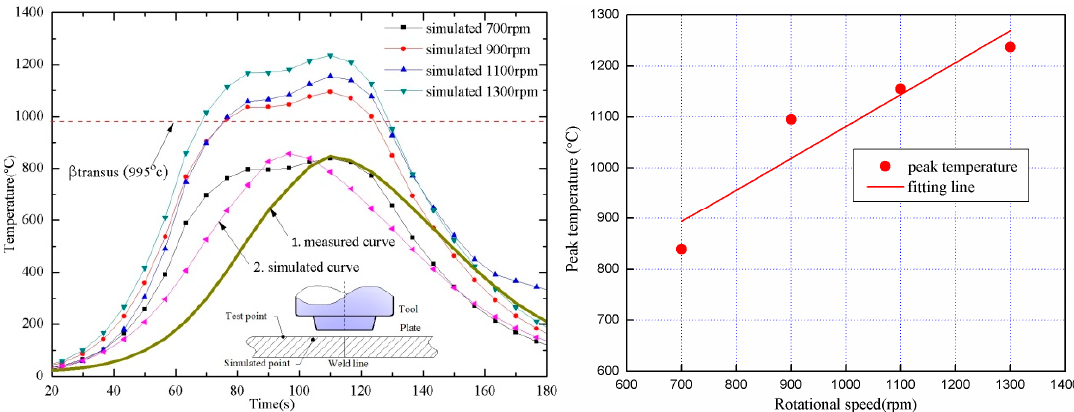
Figure 6. Temperature profiles (at welding speed of 20 mm/min). ( a ) Temperature history profiles at various rotational speed; ( b ) peak temperature distribution at different rotational speeds.